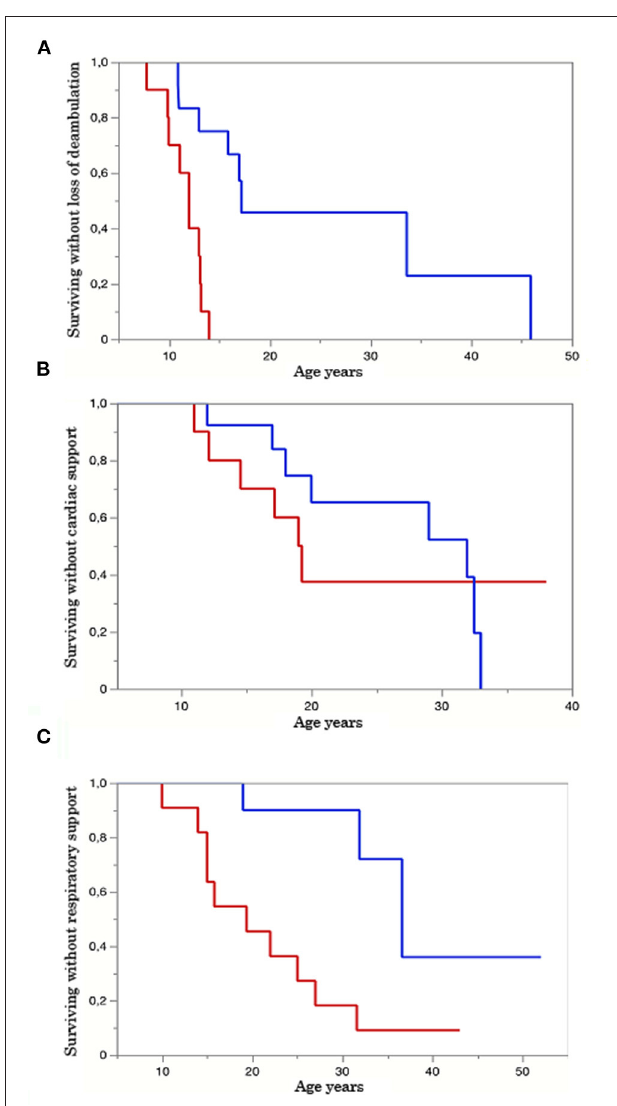
FIGURE 2 | Kaplan–Meyer (KM) survival curve. Group A red line, group B blue line. The Y axis represents the percentage of survival, and the X axis shows the age in years. (A) KM curves of patients surviving without loss of ambulation in both groups A and B. p -value = 0.0005. (B) KM curves of patients surviving without assuming cardiological therapy in groups A and B. p -value = 0.14. (C) . KM curves of patients surviving without respiratory aids in groups A and B. p -value =